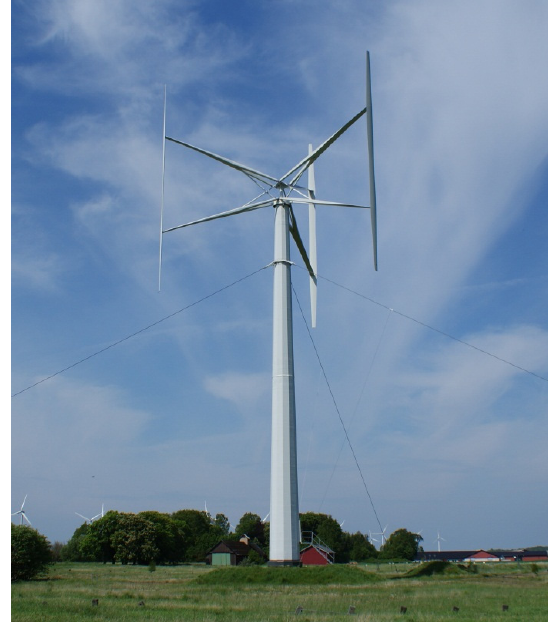
Figure 2. The T1 ‐ turbine.